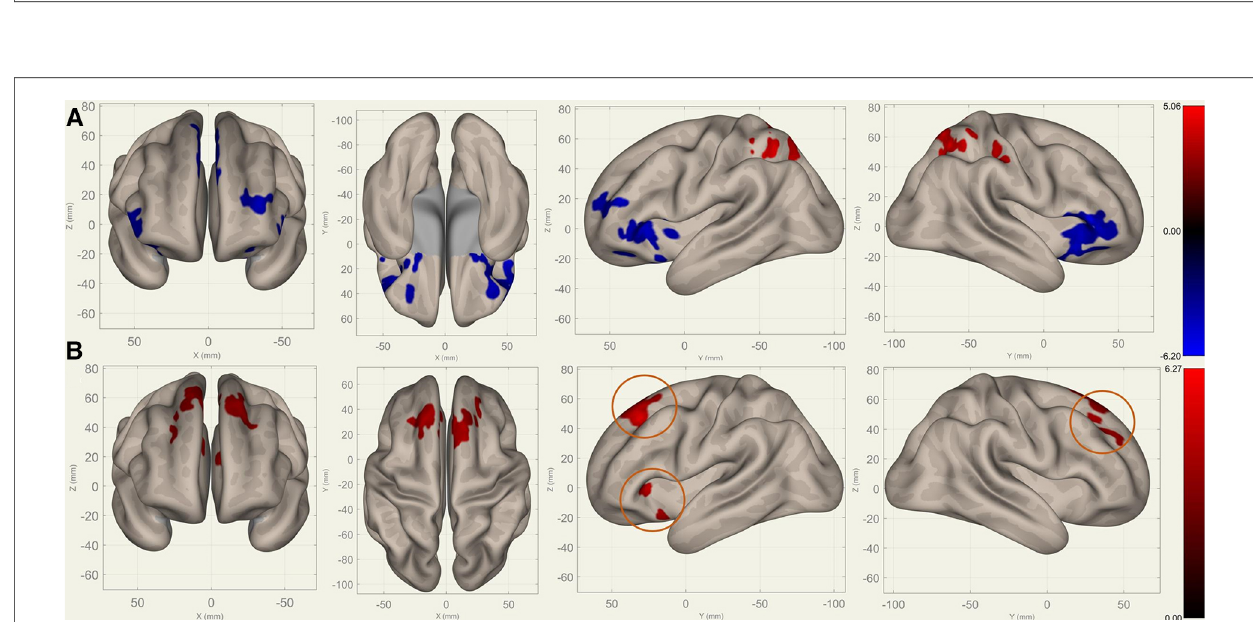
FIGURE 5 Perioperative seed-based connectivity changes in the bilateral pallidi (seed points) ( T . 3 : 25, voxel threshold p (cid:1) unc , 0 : 01, cluster threshold p (cid:1) FDR , 0 : 05). ( A ) S1>S0: The decreases were most prominent in the bilateral frontal poles (MNI [ + 10 þ 12 þ 00], cluster size: 2469 voxels, peak p (cid:1) unc , 0 : 001, size p (cid:1) FDR , 0 : 001) and the right superior frontal gyrus (MNI [ þ 00 þ 24 þ 54], cluster size: 1289 voxels, peak p (cid:1) unc , 0 : 001, size p (cid:1) FDR , 0 : 001). ( B ) S2>S1: The increases were most prominent in the right superior frontal gyrus (MNI [ þ 10 þ 36 þ 38], cluster size: 2004 voxels, peak p (cid:1) unc , 0 : 001, size p (cid:1) FDR , 0 : 001) and left frontal orbital cortex (MNI [ (cid:1) 22 þ 22 þ 00], cluster size: 319 voxels, peak p (cid:1) unc , 0 : 001, size p (cid:1) FDR ¼ 0 : 006). The orange circles indicate “ map expansion ” neuroplasticity after the